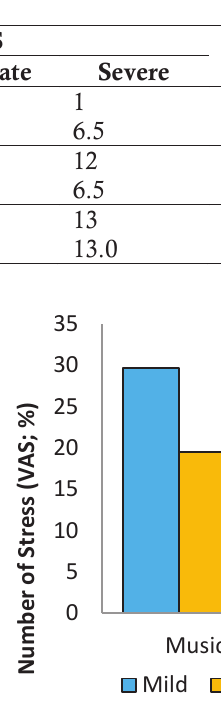
Table.2. Table of cross influence of listening to classical music on stress alleviation in students while